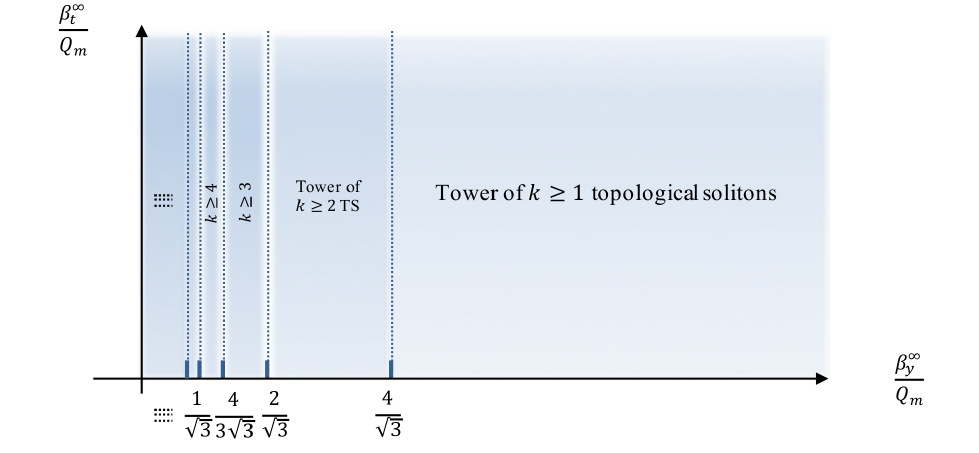
Figure 3 . Phase space of locally-stable topological